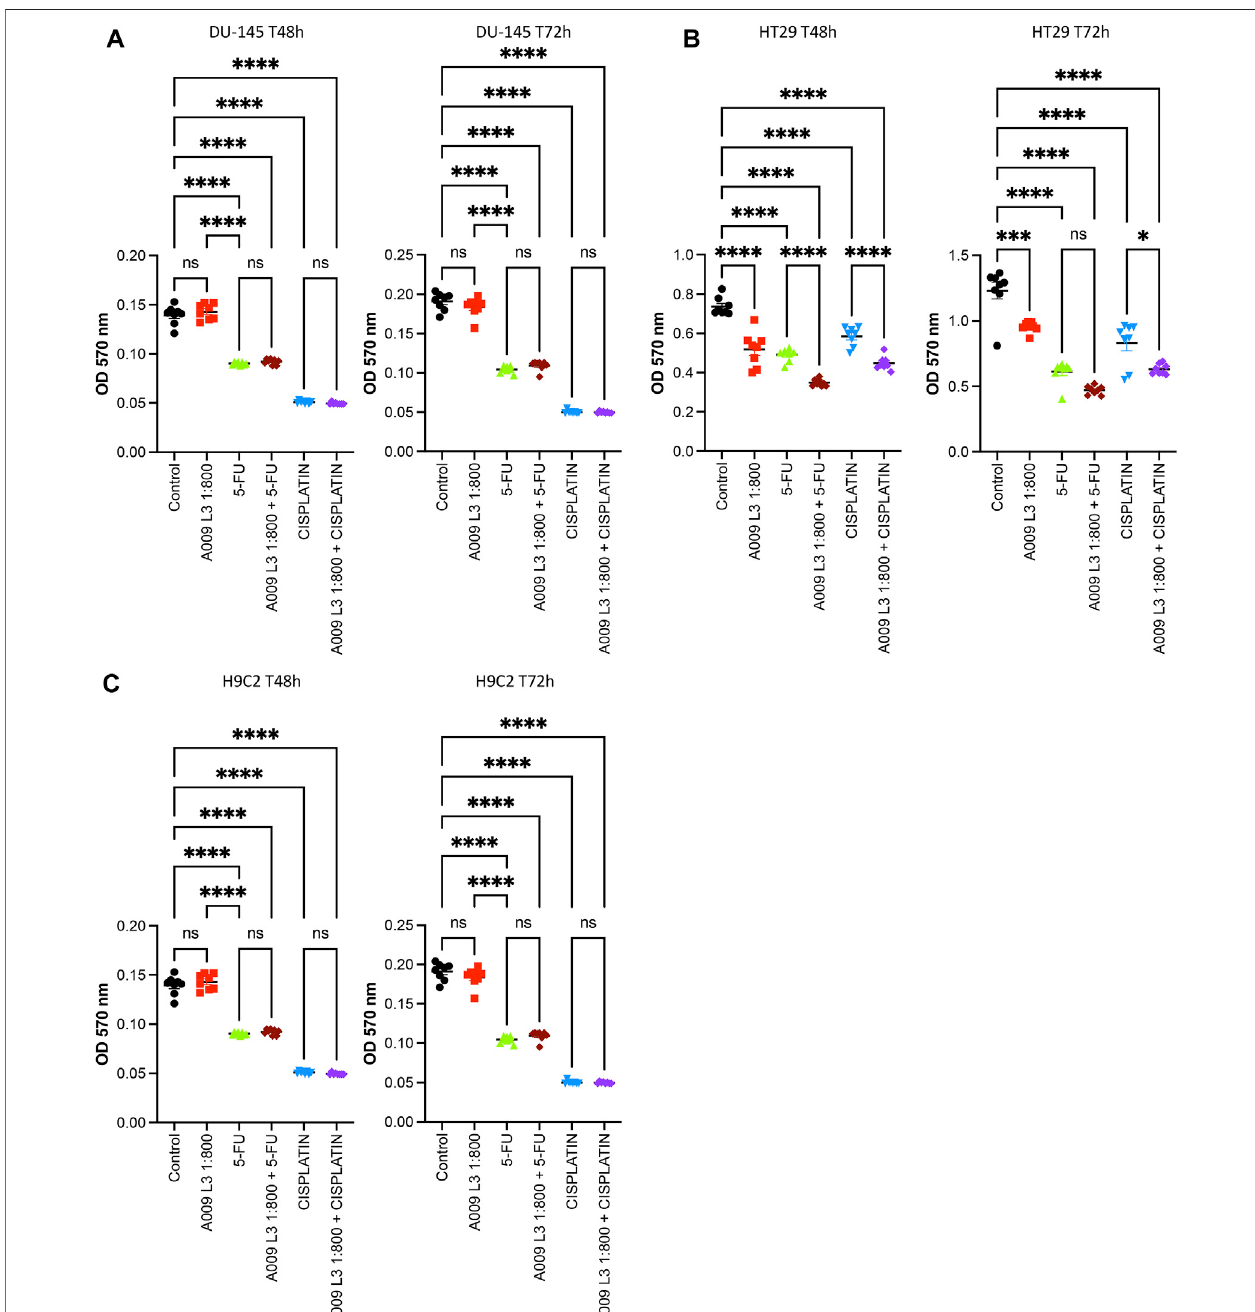
FIGURE3| ActivitiesofA009extractscombinedwithchemotherapyontumorcellsandcardiomyocytes.A009(batchL3)deceasestheproliferationrateoftumors cells in vitro [ (A) : DU-145 PCa and (B) : HT29 CRC and has additive effects on the cisplatin and the 5-Fluorouracil (5FU) effects. The cardiomyocytes proliferation rate is not affected by A009 alone (C) , and reduced proliferation by 5FU and cisplatin is not further decreased by A009 in vitro . Control: vehicle control. Data are showed as mean ± SEM, one-way ANOVA, * p < 0.05, ** p < 0.01, *** p < 0.001, **** p < 0.0001.